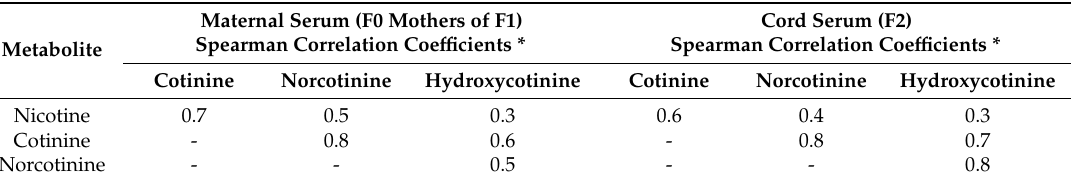
Table 2. Spearman correlation coe ffi cients of nicotine and its metabolites (nM) in maternal (F0 mothers of F1 generation) and cord sera (F2 generation).